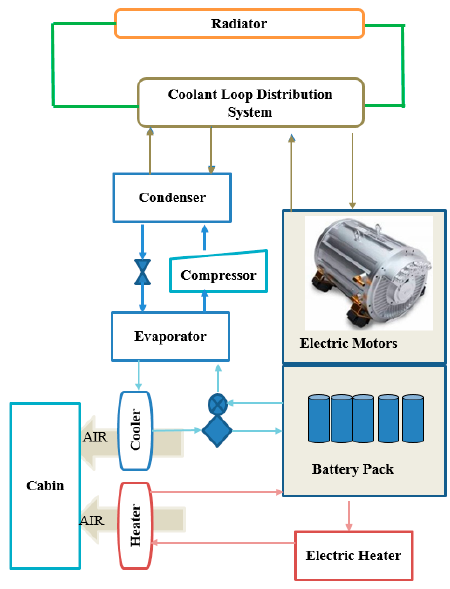
Figure 7. The ITM system of the NREL CFL [131].